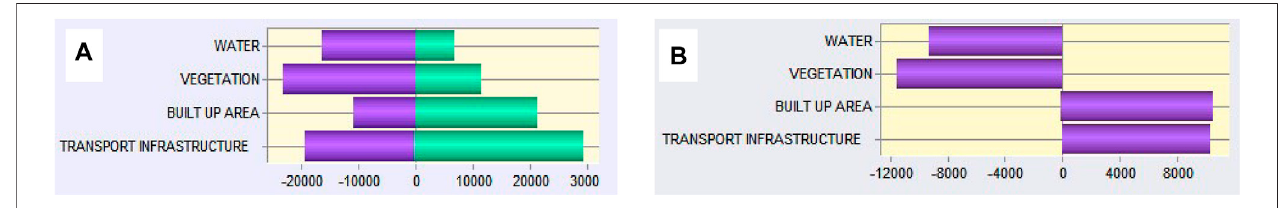
FIGURE 10 | (A) Gain and loss chart (B) net change